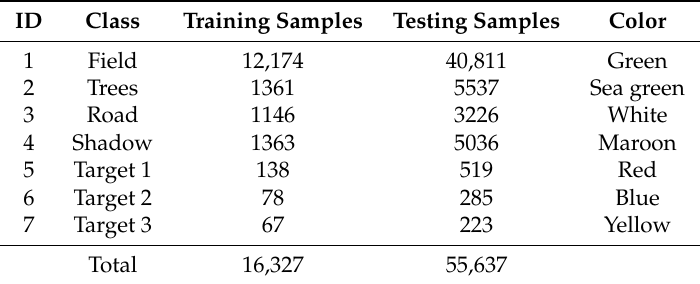
Table 2. Training and testing samples used in the